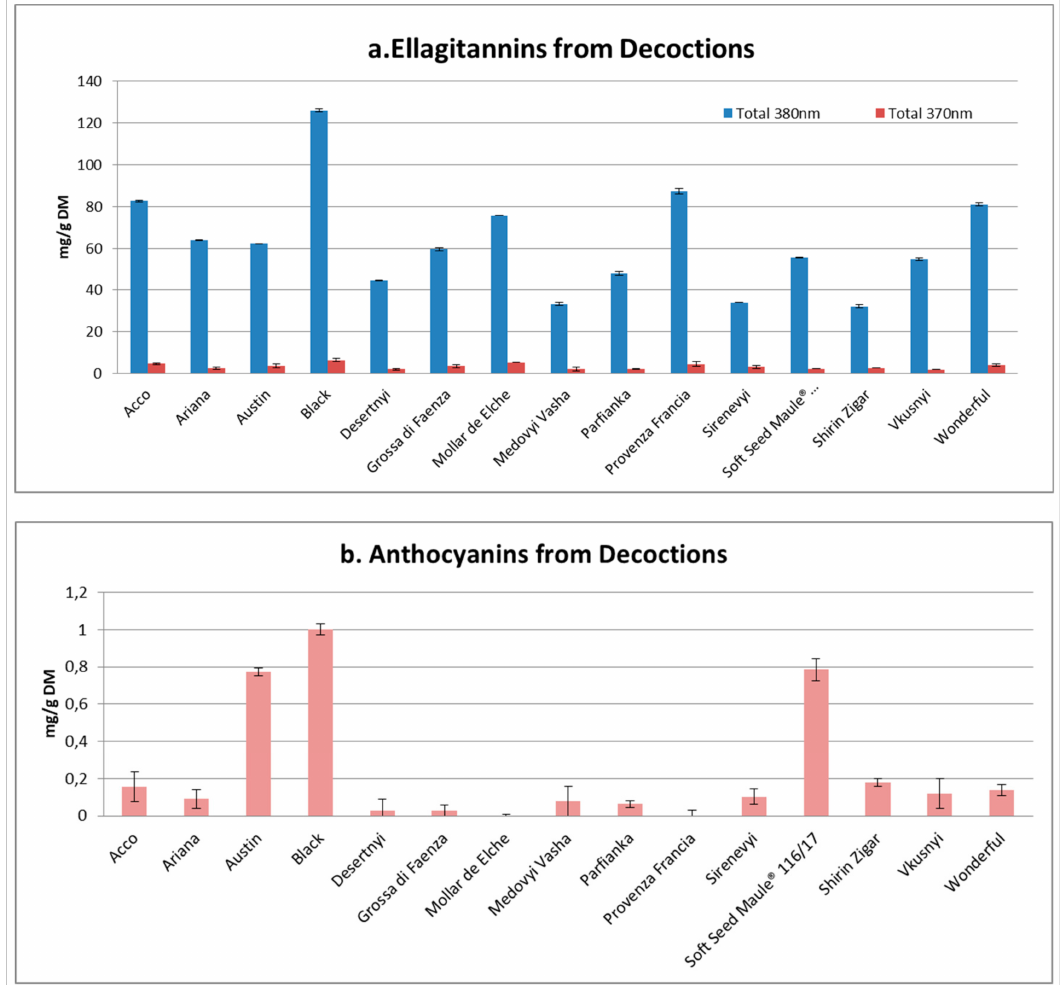
Figure 1. Ellagitannins ( a ) and anthocyanins ( b ) from decoctions. Ellagitannin content is expressed as mg of punicalagin on g of dried matter when the λ MAX is close to 380 nm and as mg of ellagic acid on g of dried matter when the λ MAX is close to 370 nm. The content of anthocyanins is expressed as mg of oenin on g of dried